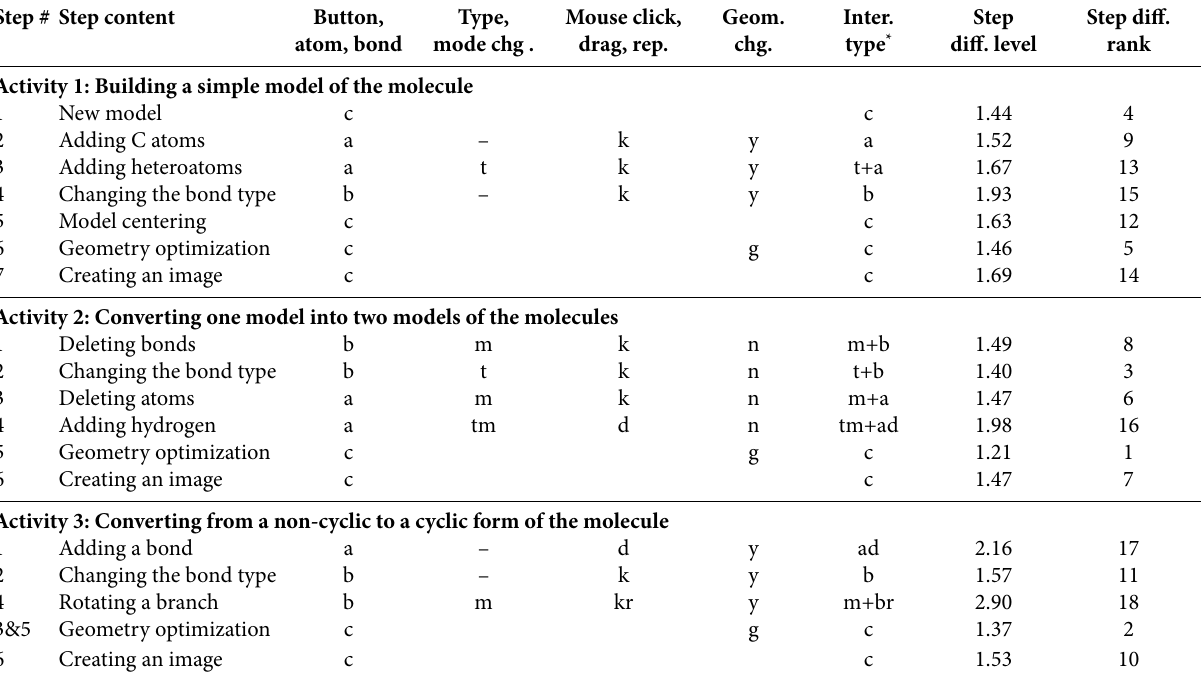
Table 8: Steps for each activity with interaction types, step difficulty levels and